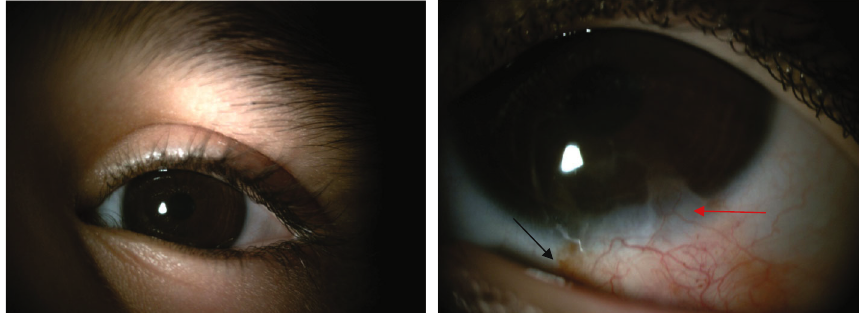
Figure 4: After 6-month follow-up. Sectoral super fi cial pannus formation in the inferior temporal quadrant with distinct borders, pannus formation (red arrow), and an adhesion band formation (black arrow). Table 1: Ocular injury after exposure to a BB in the